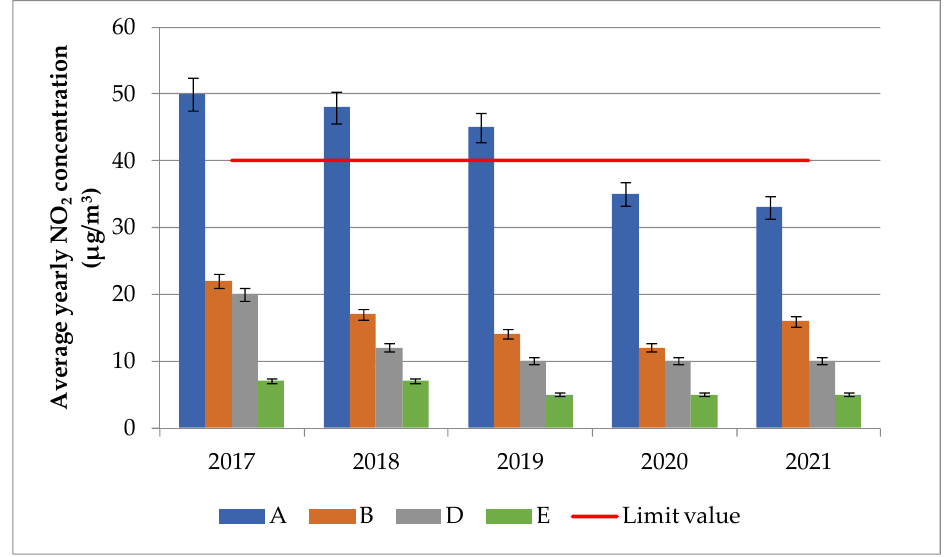
Figure 5. Average yearly NO 2 concentrations at locations A, B, D, and E between 2017 and 2021. In addition, Figures 6 and 7 present the average monthly and annual NO X concentrations at chosen locations during studied years, and Table 2 shows average, minimal, and maximal values with standard deviation. The plots for daily average concentrations of NO X at all locations during the study period are in the SM (Figure S3). Average, minimum, and maximum values with standard deviations for all studied years for each pollutant are additionally included (SM, Table S3).